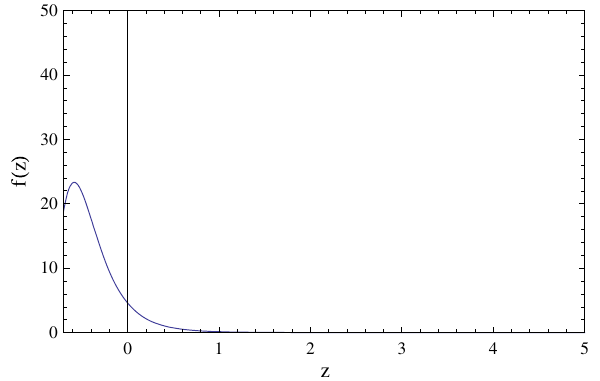
Fig. 28 Variation of f ( z ) with the variation of z (Model IV) by con- sidering the best fit values w 0 = − 0 . 766 ,w 1 = 0 . 307